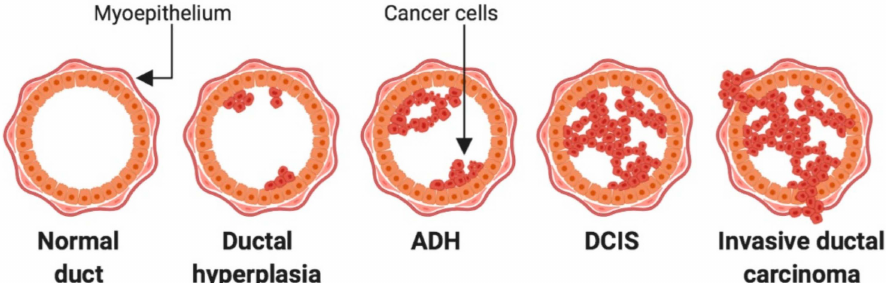
Figure 1. Stages of breast cancer development. Tumour cell initiation and expansion within